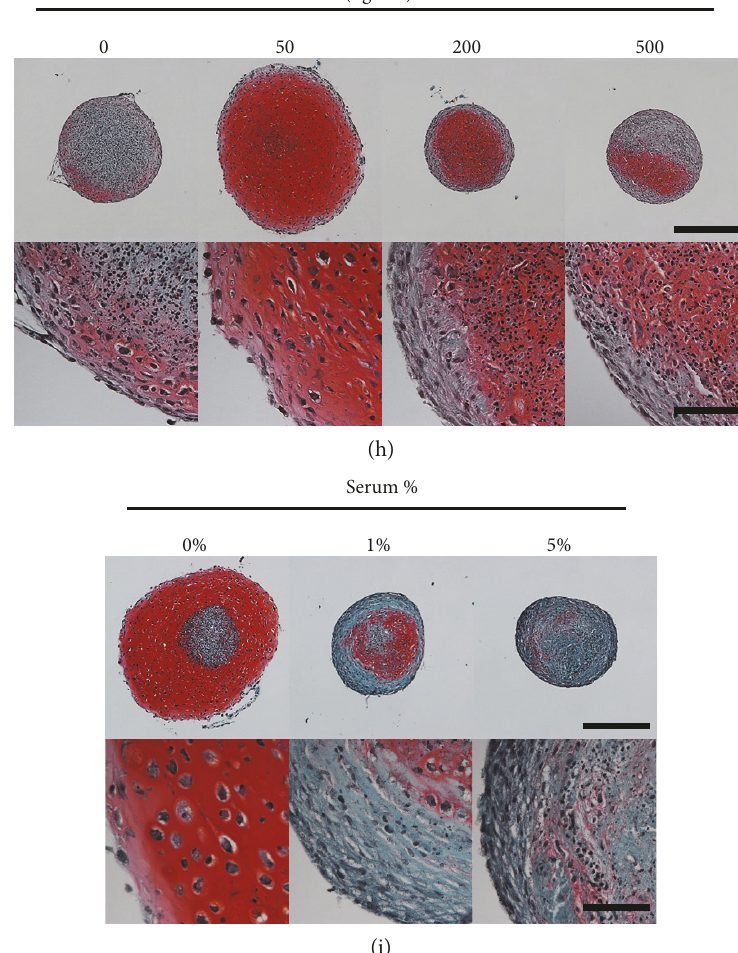
Figure 4: Chondrogenesis of iNCMSCs. The representative data from three lines is shown. (a) Safranin-O staining of chondrogenic pellet stimulated with TGF β 3 and BMP2 at day 28. High magni fi cation image is shown in the right panel with the same frame. (b, c) Immunostaining for COL2 and SOX9 of chondrogenic pellet at day 28. (d) The pellet size of chondrogenic pellets during culture. (e) Deposition of sulfated glycosaminoglycan in chondrogenic pellets during culture. (f) The alteration of chondrogenesis-related gene expression. (g) mRNA expression levels for type 10 collagen in long-term culture and immunostaining for type 10 collagen at day 28 in chondrogenic pellets. (h) Saf-O images of chondrogenic pellet culture with TGF β 3 (10 ng/mL) and various concentrations of BMP2 (0 – 500 ng/mL) for 28 days. (i) Saf-O images of chondrogenic pellet cultures in TB media with addition of variable serum concentrations for 28 days. Scale bars =500 μ m (a, h, i) and 100 μ m (b, c, and high-magni fi ed images of a, h, i). Data are expressed as mean ± SD for three pellet replicates (d – g). Abbreviations: Saf-O: Safranin-O staining; COL2: type 2 collagen; sGAG: sulfated glycosaminoglycan; COL10: type 10